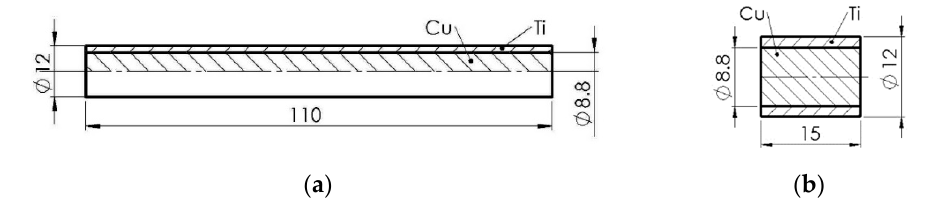
Figure 1. The geometry of the samples used in the tests: ( a ) sample for the tensile test, ( b ) sample for microscopic analysis.